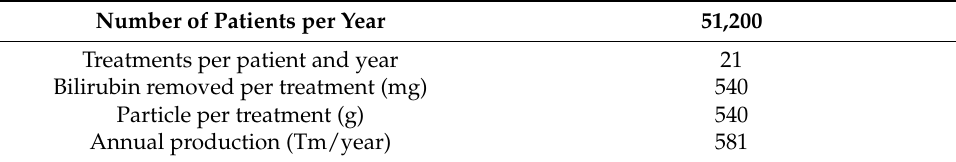
Table 5. Annual production of HSA functionalized St-MMA-GMA-PEGMA.